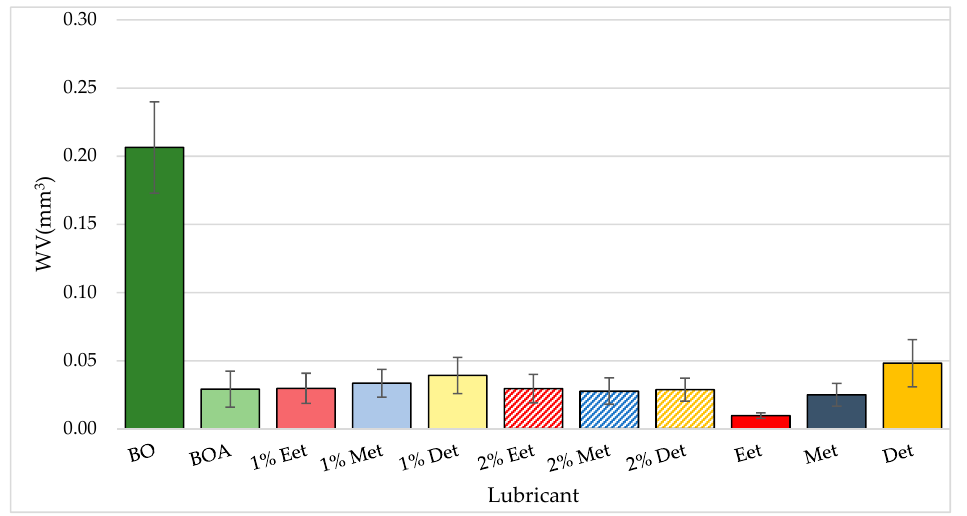
Figure 6. Average values of the wear volume of steel disks after tests lubricated with BO, BOA, neat PILs, and PIL blends 1 wt.% Eet + BO, 1 wt.% Met + BO, and 1 wt.% Det + BO.